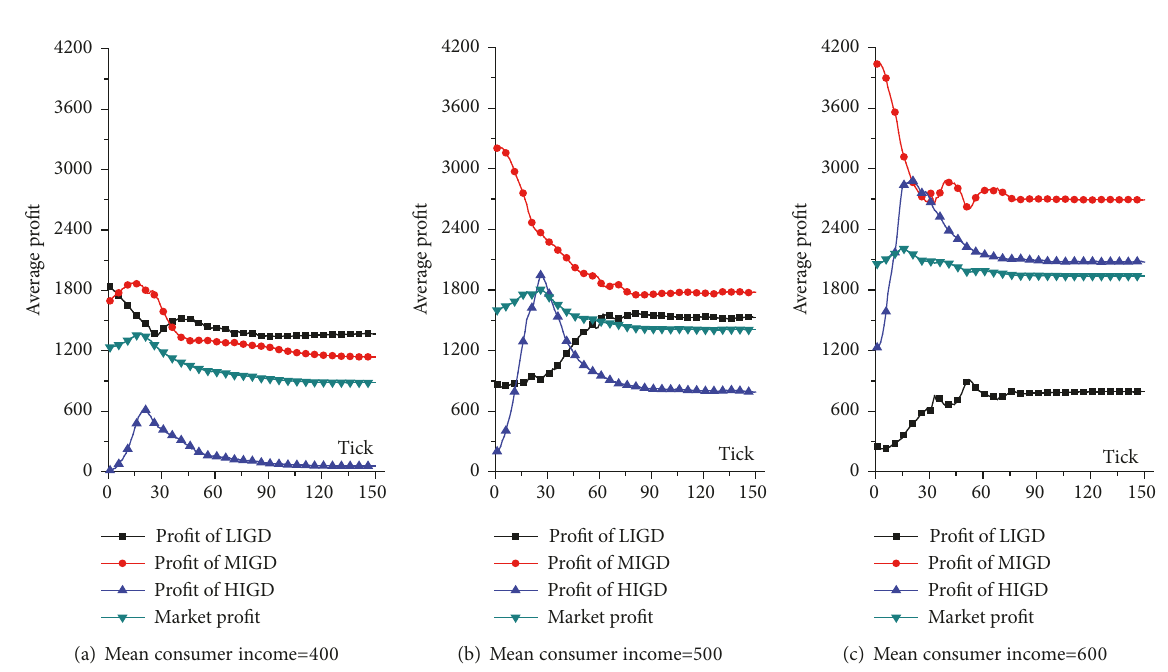
Figure 7: Profit evolution of manufacturers under different